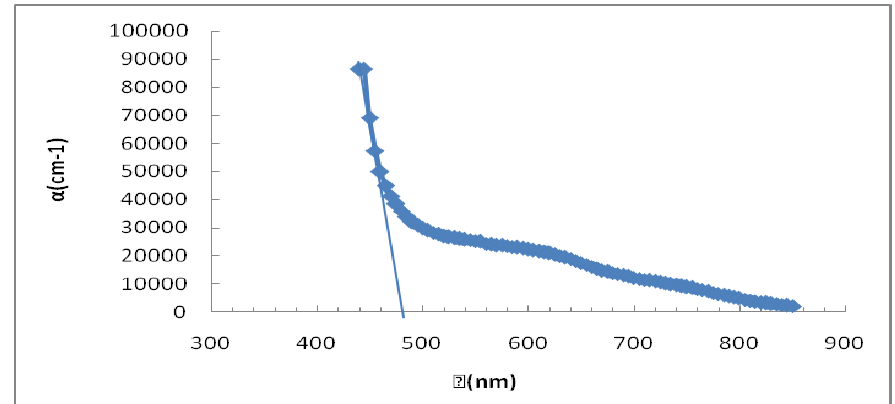
Fig.5: Absorption coefficient as a function of wavelength for polymer thin film at thickness 800